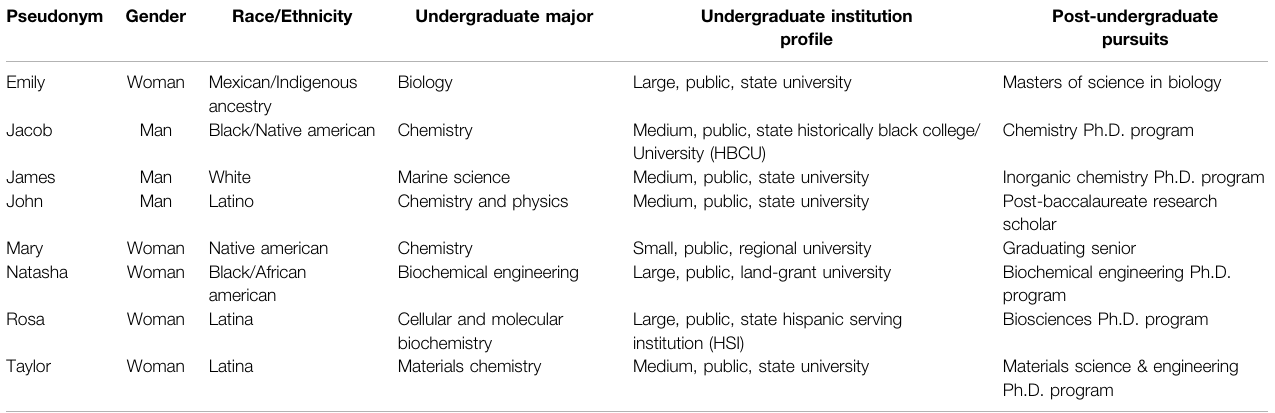
TABLE 1 | Participants ’ pro fi